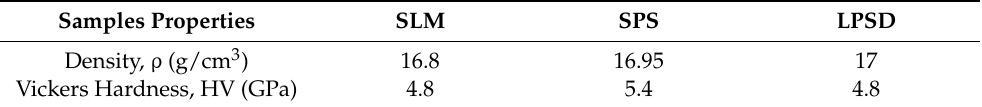
Table 2. Density and Vickers hardness of W – 5Ni – 2Fe samples produced by various technologies. Samples properties